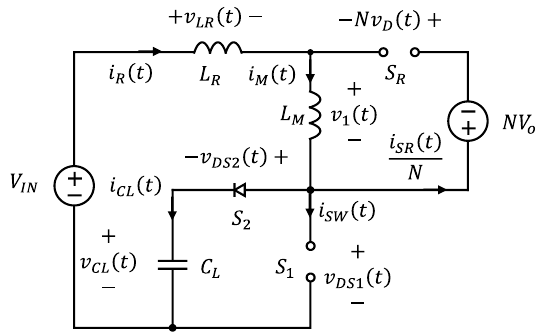
Figure 10. Equivalent circuit in state 5.